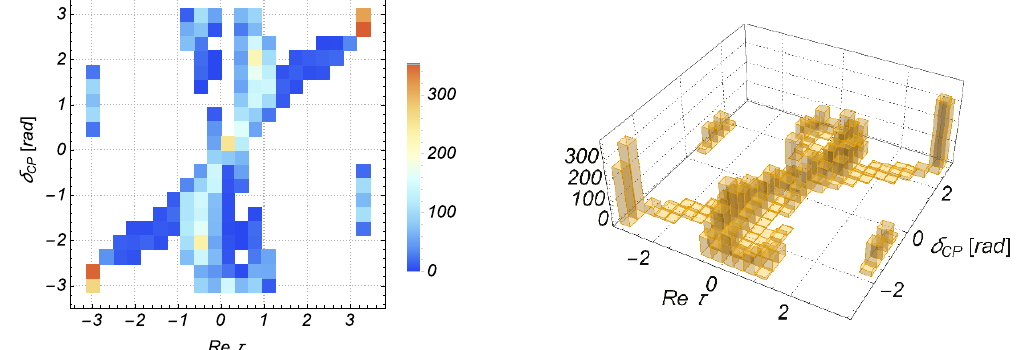
Figure 19 . Distributions of CP-violating phase δ CP vs. real part of complex structure modulus Re τ for Im τ = 1 . 8 in Pattern VII.